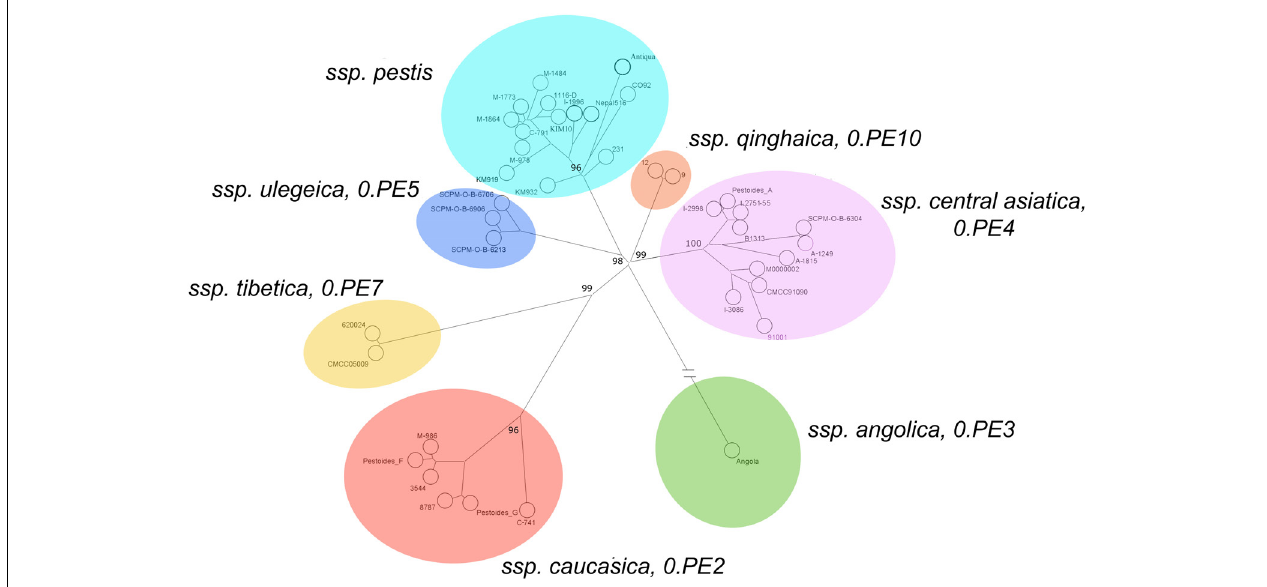
FIGURE 6 | Current population structure of Y. pestis revealed by core genome SNP analysis (based on 2413 core SNPs of 39 genomes of strains, belonging to different phylogenetic branches and populations), and enhancement of subspecies classification of Y. pestis . Maximum parsimony tree, Bionumerics 7.6 software